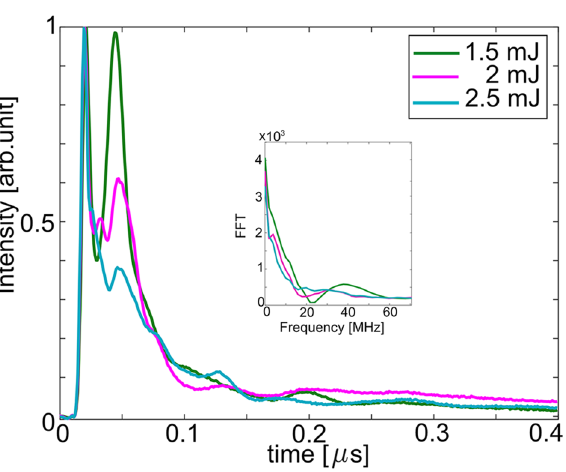
Figure 9. Recorded single-shot LIGS signals in N 2 at fs-laser pulse energies 1.5 mJ (green curve), 2 mJ (pink curve) and 2.9 mJ (blue curve) respectively. The inset shows the Fourier analysis of the signals at these